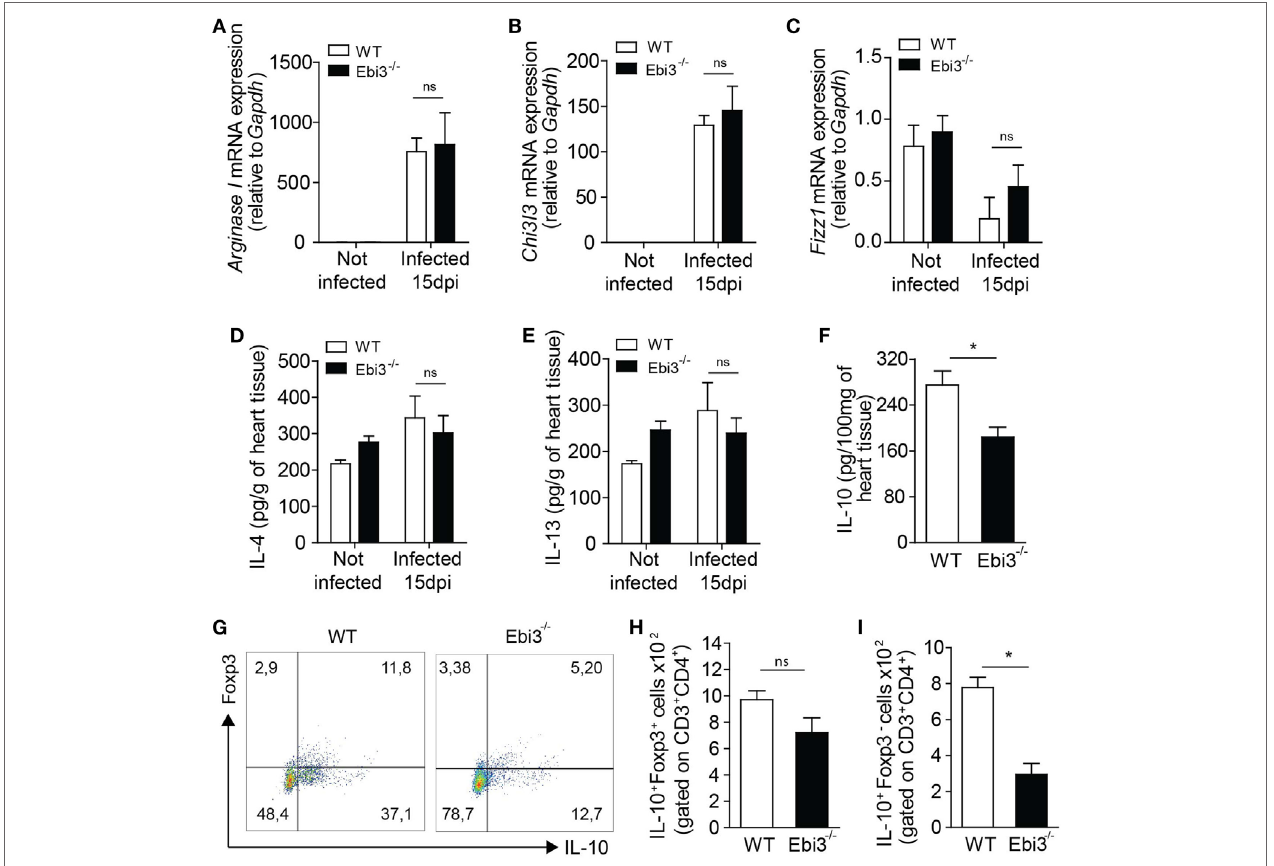
FigUre 7 | Cardiac inflammation of Ebi3-deficient mice is depicted by lower infiltration of IL-10-producing Tr1 cells. (a–e) Expression of key markers associated with alternatively activated macrophages was analyzed in the heart tissue of wild-type (WT) and Ebi3-deficient mice after 15 d.p.i. Gene expression of ArgI (a) , Chi3l3 (B) , and Fizz1 (c) was assessed by RT-PCR. IL-4 (D) and IL-13 (e) production was measured in the homogenate of heart tissue by ELISA. (F) Production of IL-10 was evaluated by ELISA in the homogenate of heart tissue 15 d.p.i. (g,h,i) Representative plot and number of CD3 + CD4 + IL-10 + Foxp3 + and CD3 + CD4 + IL- 10 + Foxp3 − cells isolated from the heart tissue and evaluated as in (a,B) . Data shown are expressed as mean ± SEM *( P < 0.05) and are representative of three independent experiments ( n =